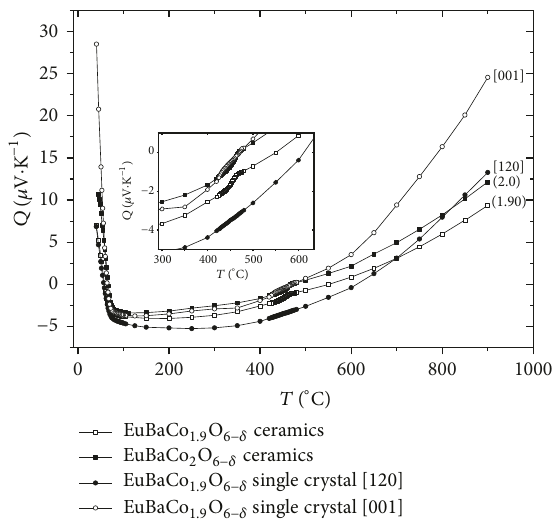
Figure 5: Normalized change of the lattice parameters of polycrys- Figure 6: Thermo-EMF coefficient as a function of temperature talline samples of EuBaCo 2− O 6−𝛿 ( 𝑥 = 0 – 0.1 ) at room temperature x in air for polycrystalline (ceramic) samples EuBaCo 2.0 O 6−𝛿 and in air as a function of cobalt deficiency. EuBaCo 1.90 O 6−𝛿 and single crystalline EuBaCo 1.90 O 6−𝛿 measured along the 𝑎𝑏 -plane ([ 120 ]) and along the c -axis ([ 001